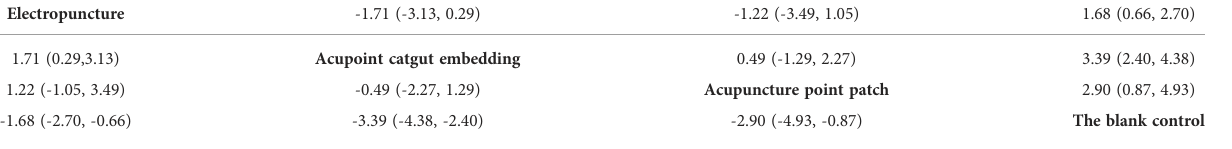
TABLE 6 Network meta-analysis ladder table of body mass index.